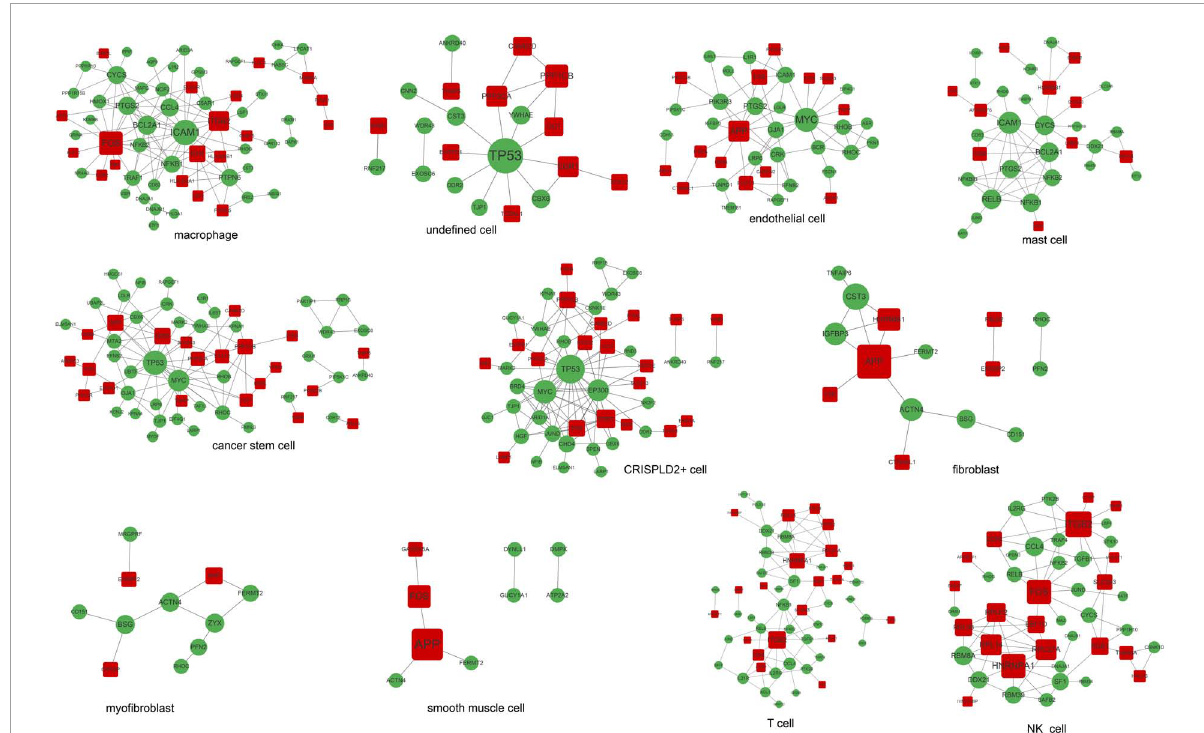
FIGURE4 The PPI networks are associated with disease-related genes in each cell type. Red squares represent upregulated mRNAs; green circles represent downregulated mRNAs; gray lines represent protein interactions.